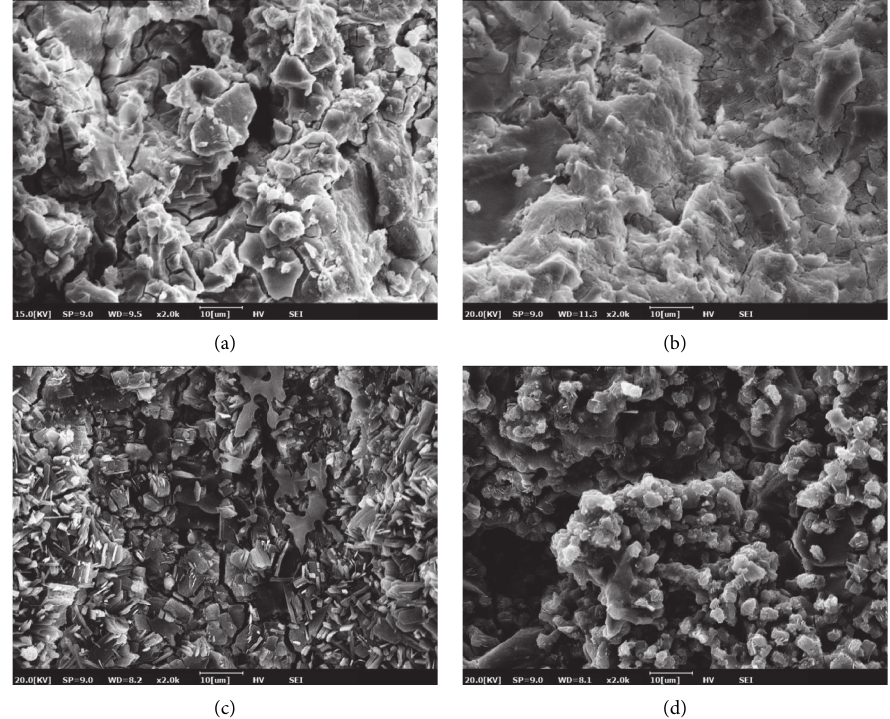
Figure 12: SEM images of hardened MPC-based grouting material after curing for 28 days: (a) C1; (b) C2; (c) C4; and (d)